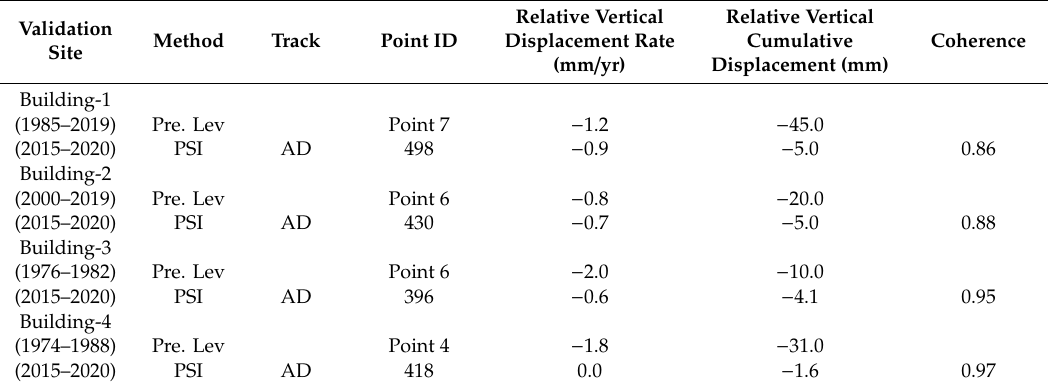
Figure 8. The east–west displacement rate of the combined ascending and descending PS points overlaid on the Topographic map of the city of Gävle. Negative values denote for west movement while the positive denotes for east movement. Coordinate system: SWEREF 99. Unit: mm / yr. Table 2. Comparison between the computed precise leveling rates (Pre. Lev) using four di ff erent leveling records relative to four di ff erent BMs, and the relative vertical rate of the generated combined PS points in the four validation buildings using the ascending and descending combination of the 41 and 50 SAR images, respectively, collected between 2015 and